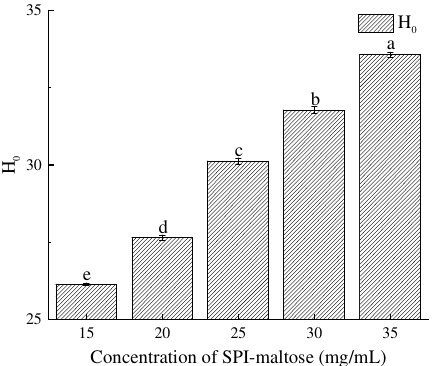
Figure 2. H 0 at different concentration of SPI–maltose. Different letters (a–e) indicate statistically significant differences ( p ≤ 0.05), according to ANOVA (one-way) and the Tukey test.